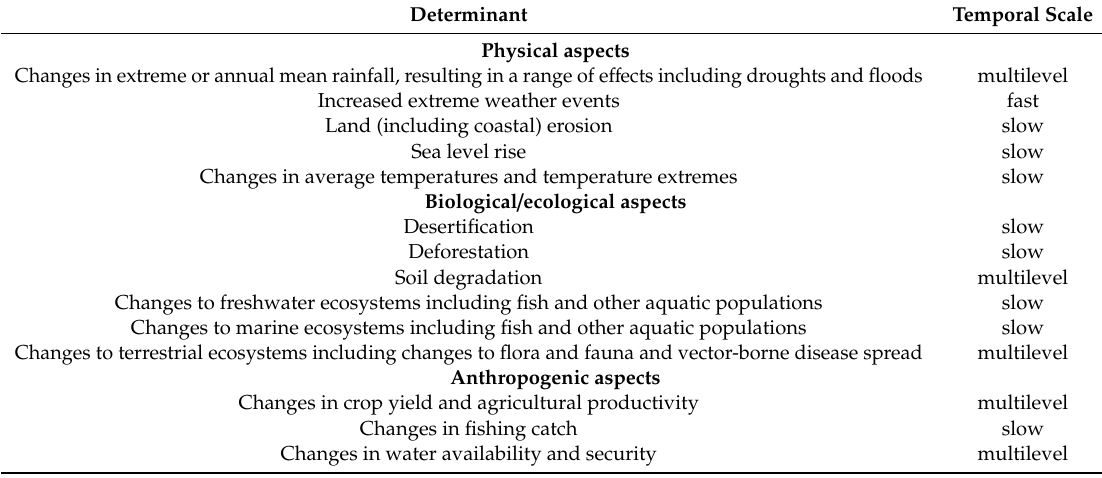
Table 2. Key climate change characteristics that increase population vulnerability to environmentally induced